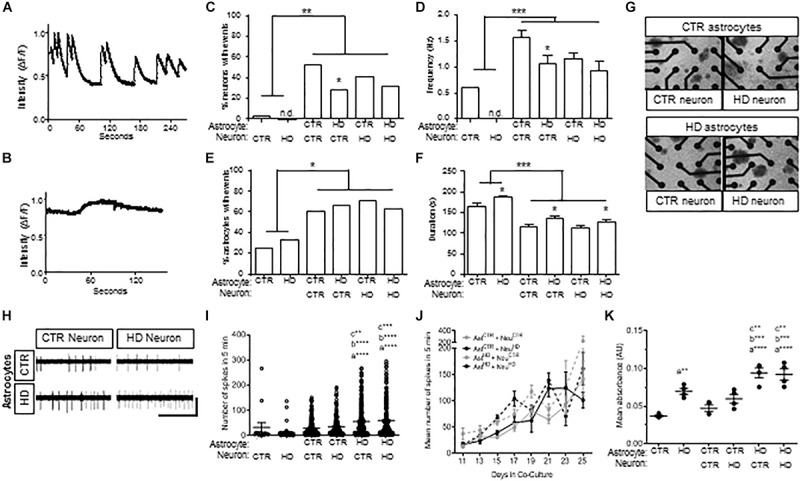
Co-cultures of HD (HD109) and control (CTR33) astrocytes and neurons demonstrate alteration in neuronal firing at early time points and increased toxicity in response to glutamate. (A) Example traces of calcium events in control neurons with control astrocytes. (B) Example traces of calcium events in control astrocytes with control neurons. (C) Percentage of neurons with calcium events is higher in co-culture, but lower in HD astrocyte co-culture compared to control astrocyte co-culture. (D) Frequency of events is higher in neurons in co-culture compared to mono-culture, but less frequent in HD astrocyte co-culture compared to control astrocyte co-culture. (E) Percentage of astrocytes with calcium transients is greater in co-culture compared to mono-culture. (F) Astrocytes in mono-culture had longer transients than in co-culture, and HD astrocytes in mono-culture had longer transients than control astrocytes. Co-culture of control or HD neurons with HD astrocytes showed a longer duration of calcium transients compared to co-culture with control astrocytes. (G) Representative images of astrocyte and neuron co-cultures around the 16 electrodes (black circles) of a 48-well MEA plate. (H) Example electrode traces showing spikes detected from control (CTR) or HD neurons that are co-cultured with CTR or HD astrocytes. Scale bar: 12.5 μV vertical by 5 s horizontal. (I) Spontaneous activity from control and HD co-cultures. Significance between conditions denoted as “a”: from NeuHD, “b”: from NeuCTR + AstCTR, “c”: from AstCTR + NeuHD. (J) No difference in total mean spike number per neuron in co-culture conditions during daily 5 min recordings over the course of 16 days. Data is presented as separated by the neuron co-culture (gray lines, control neurons; black lines, HD neurons), with solid lines representing control astrocytes and dashed lines indicating HD astrocytes. (K) Mean absorbance values of LDH activity in media after 12 h incubation with 100 μM glutamate at 4 time points over 16 days. Significance between conditions denoted as “a”: from AstCTR, “b”: from AstCTR + NeurCTR, “c”: from AstCTR + NeuHD. Ast, astrocyte; Neu, neuron; CTR, control. Calcium imaging: cells were analyzed from more than three separate experiments using a Chi squared test. MEA: activity was analyzed using Kruskal–Wallis ANOVA on ranks with Dunn’s method from three experiments with 8–66 neurons per condition at each time point. LDH, Analysis on data from triplicates measured at each of four time points across three experiments using one-way ANOVA with Bonferroni correction for multiple comparison (*p < 0.05, ∗∗p < 0.01, ∗∗∗p < 0.005, and ****p < 0.0001).